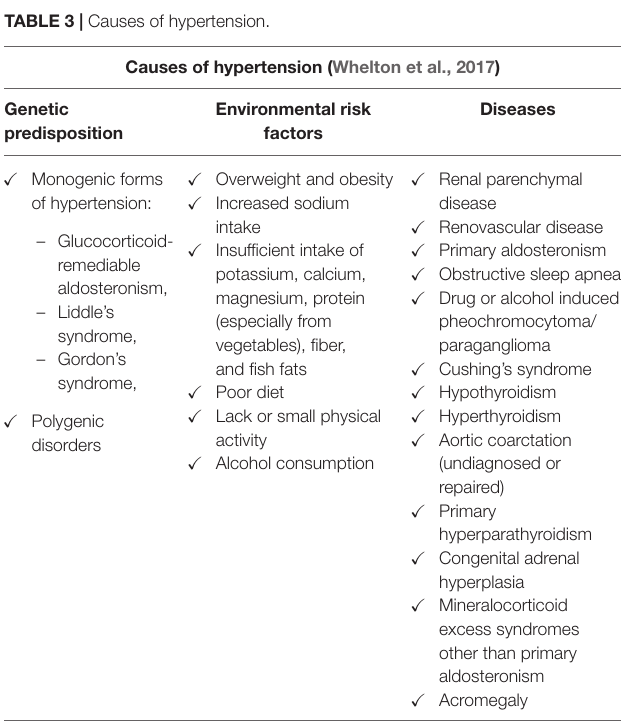
TABLE 3 | Causes of